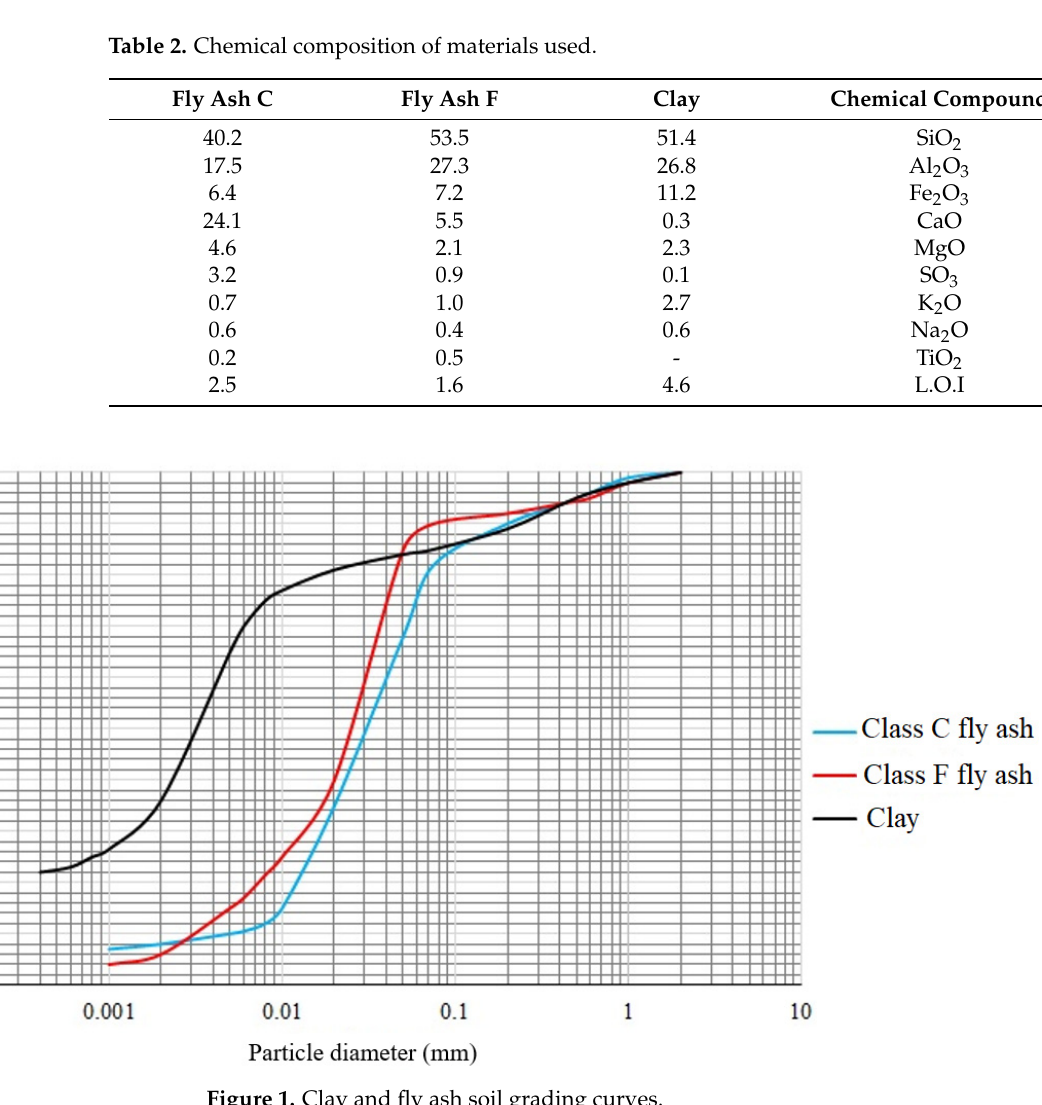
3 Table 1. Geotechnical properties of the soil. Specific Gravity